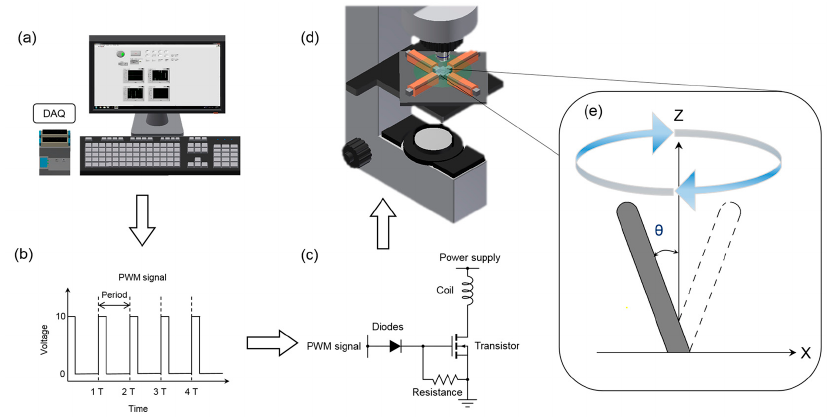
Figure 2. Schematic illustration of the magnetic actuation system. ( a ) Algorithm to generate the artificial cilia motion implemented through an in-house script; ( b , c ) Pulse-width modulation (PWM) signals were generated and applied via a switching circuit to manage the power supply; ( d ) Orientation of the microchannel corresponding to the actuation system and microscope ( e ) Schematic illustration of the artificial cilia trajectory.